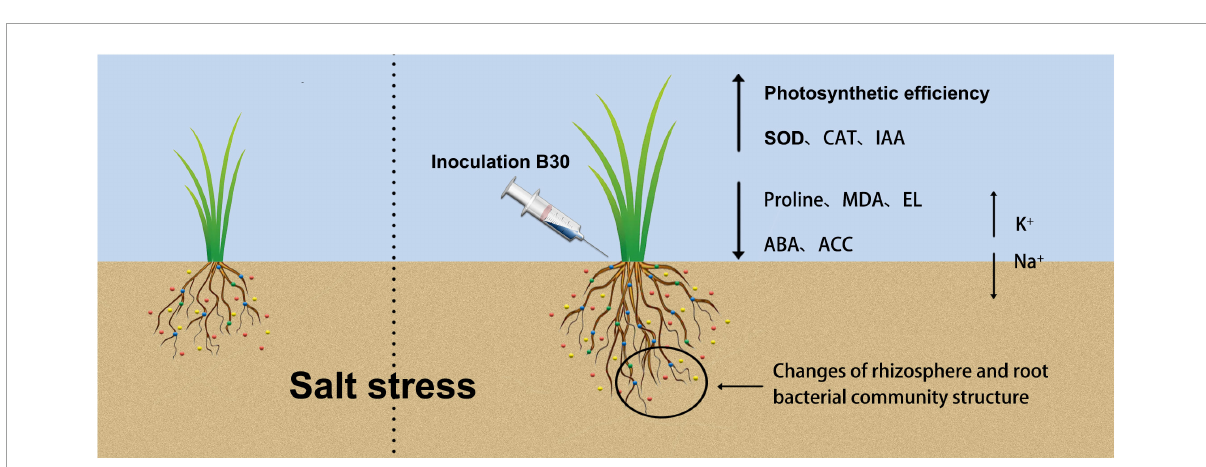
FIGURE11 A graphical abstract describing the mechanism of endophytic bacterium strain B30 enhancing salt tolerance of bermudagrass we followed to accomplish this work. Under salt stress, B30-associated bermudagrass shows an increase in shoot biomass production as compared to non-B30 bermudagrass. Inoculation of B30 changed rhizosphere and root bacterial community structure, recruited some beneficial bacteria in rhizosphere and root, then enhanced Photosynthetic efficiency, SOD, CAT, and IAA content, also decreased proline, MDA, EL, ABA, and ACC content. Besides, B30 balanced Na + and K + concentration between shoot and root of bermudagrass to alleviate the damage caused by salt